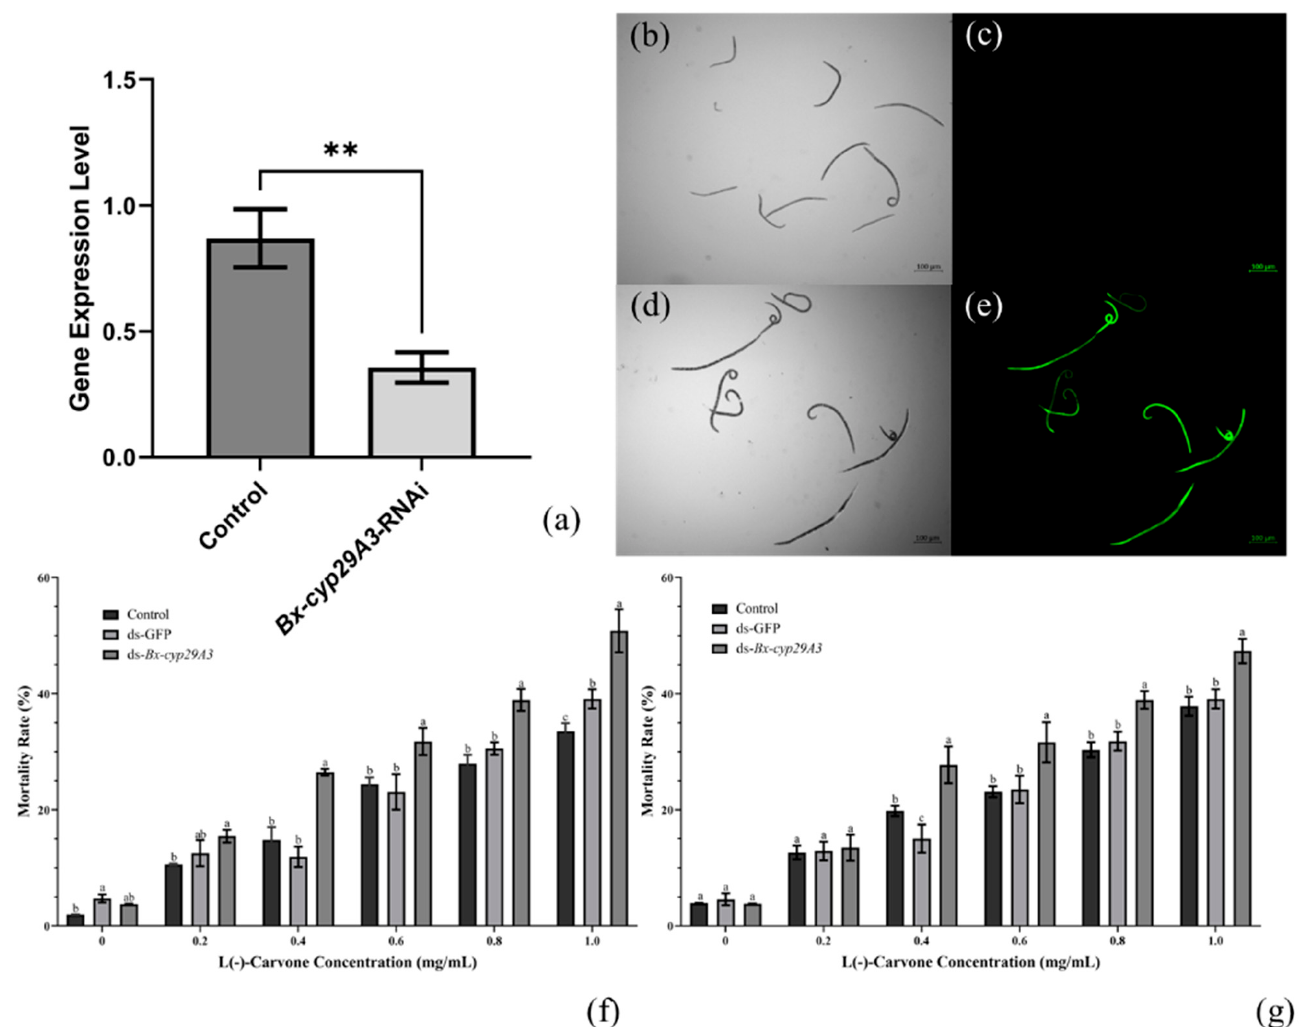
Figure 6. Bx-cyp29A3 silencing response to L( − )-carvone stress. ( a ) Relative transcript level changes between dsRNA-treated and control group; ( b – e ) FITC-treated PWNs revealed green fluorescent signal under ultraviolet light; ( f ) the mortality rates of PWNs after treatment with L( − )-carvone and exposed for 24 h; ( g ) the mortality rates of PWNs after treatment with L( − )-carvone and exposed for 36 h. Notes: Scale bar = 100 µ m. Data are mean values ± SD of different repetitions; n = 3. ** p -Value ≤ 0.01; different letters indicate statistical differences, with p ≤ 0.05 from Student’s t -test.